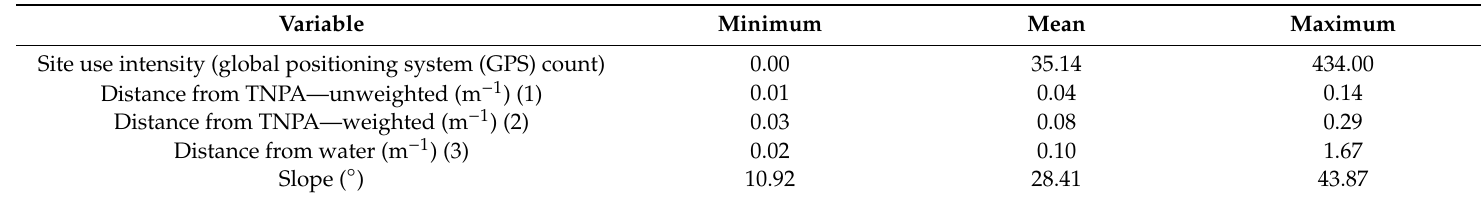
Table 1. Summary statistics for the dependent and explanatory variables used in the models. Values apply to the 30 m bu ff er zone around the 118 random points. Numbers in brackets refer to formulas detailed in the Methods section. TNPA refers to temporary night penning areas.